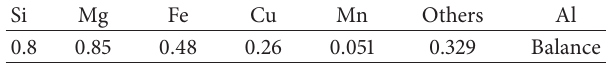
Table 1: Chemical composition of Aluminum Alloy